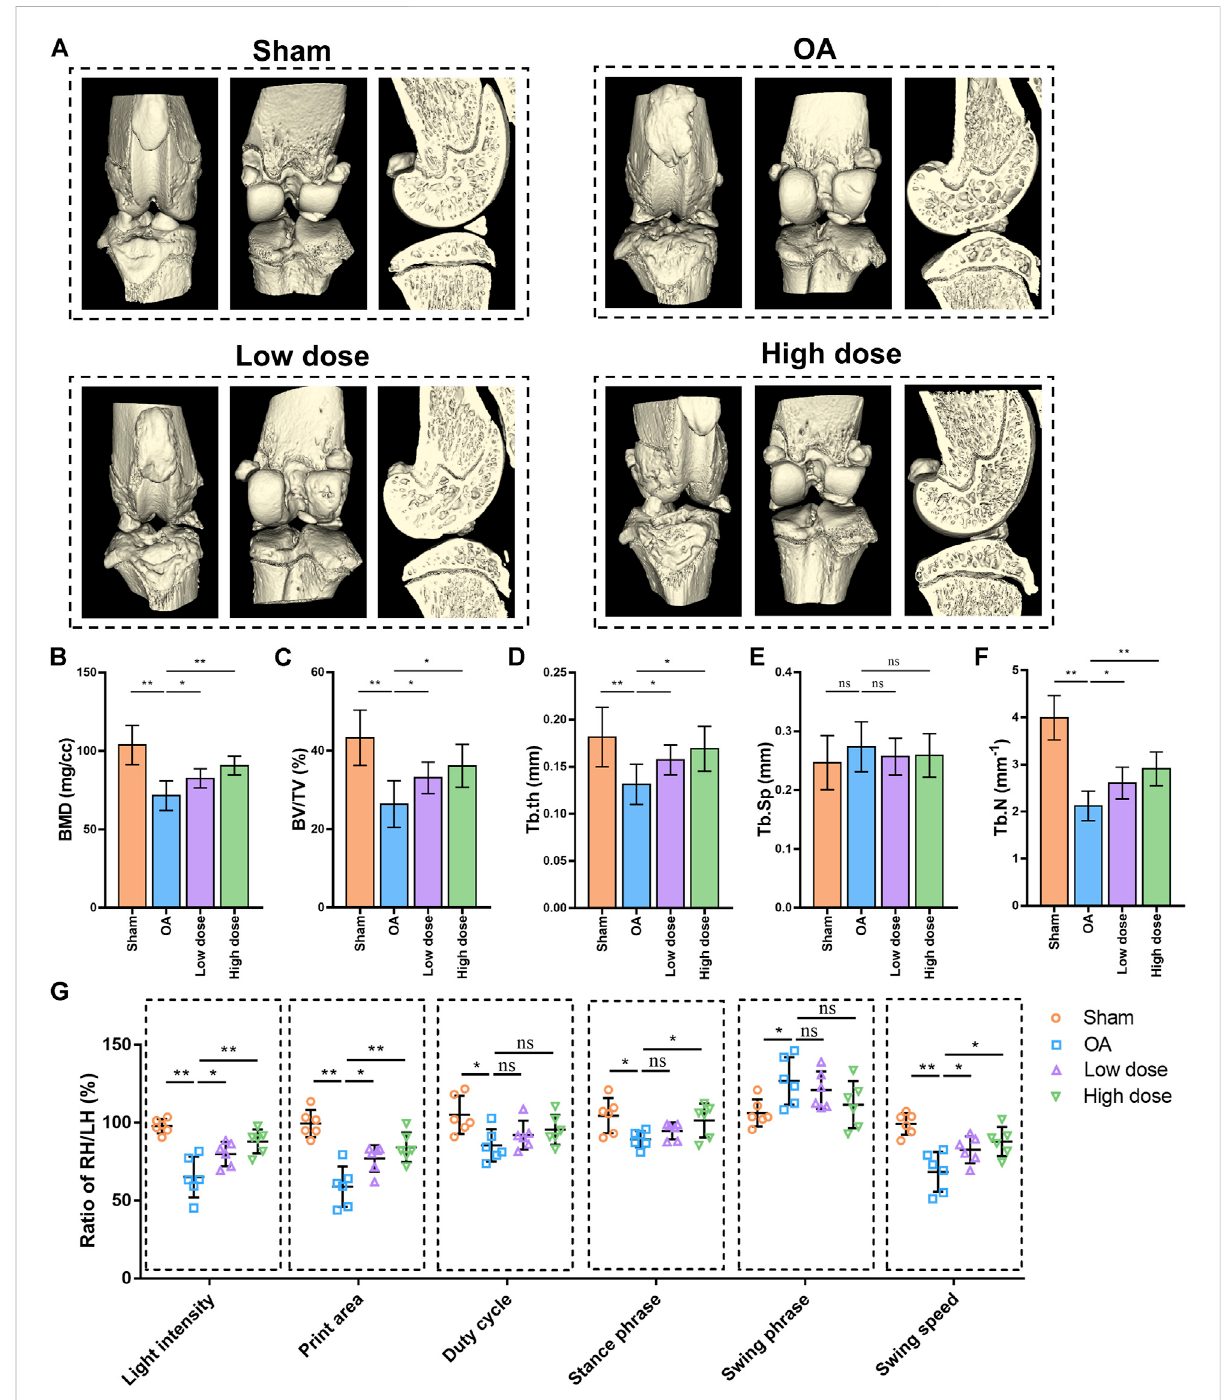
Omaveloxolone relieved pain and suppressed subchondral bone loss and microarchitecture deterioration in OA rats. (A) Representative 3D reconstructed images of right knee joints. Quantitative analysis of bone morphometric parameters of tibial subchondral bone, including BMD (B) , BV/TV (C) , Tb. th (D) , Tb. Sp (E) and Tb. N (F) . (G) Gait analysis of light intensity, print area, duty cycle, stance phrase, swing phrase and swing speed. * p < 0.05 and ** p < 0.01. n. s., not signi fi